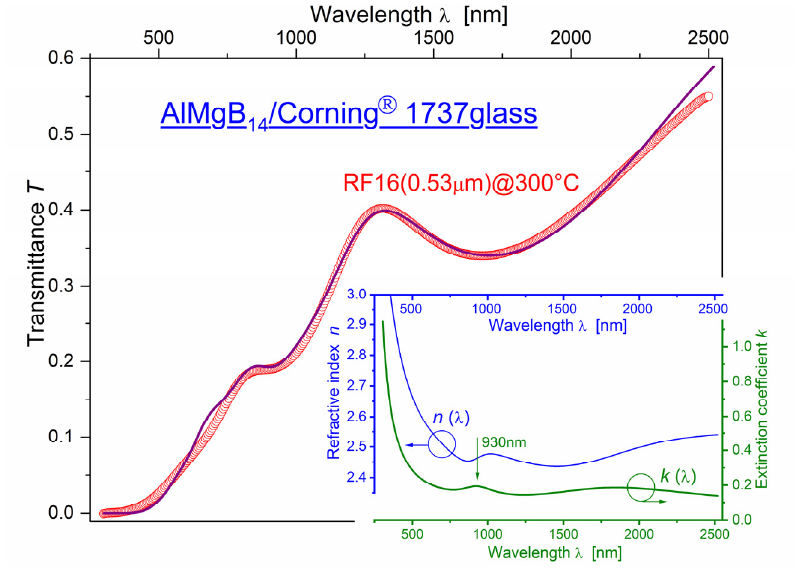
Figure 2. Circular red color symbols show experimental optical transmittance T ( λ ) in 0.53- µ m-thick AlMgB 14 film grown at 300 ◦ C onto the Corning ® 1737 glass substrate. Solid lines in the main frame and inset depict, respectively, theoretical T ( λ ), refractive index n ( λ ) and extinction coe ffi cient k ( λ ) simulated with the Swanepoel formula (see Appendix A) and Equation (1) for complex refractive index accounting for three electric dipole resonances.